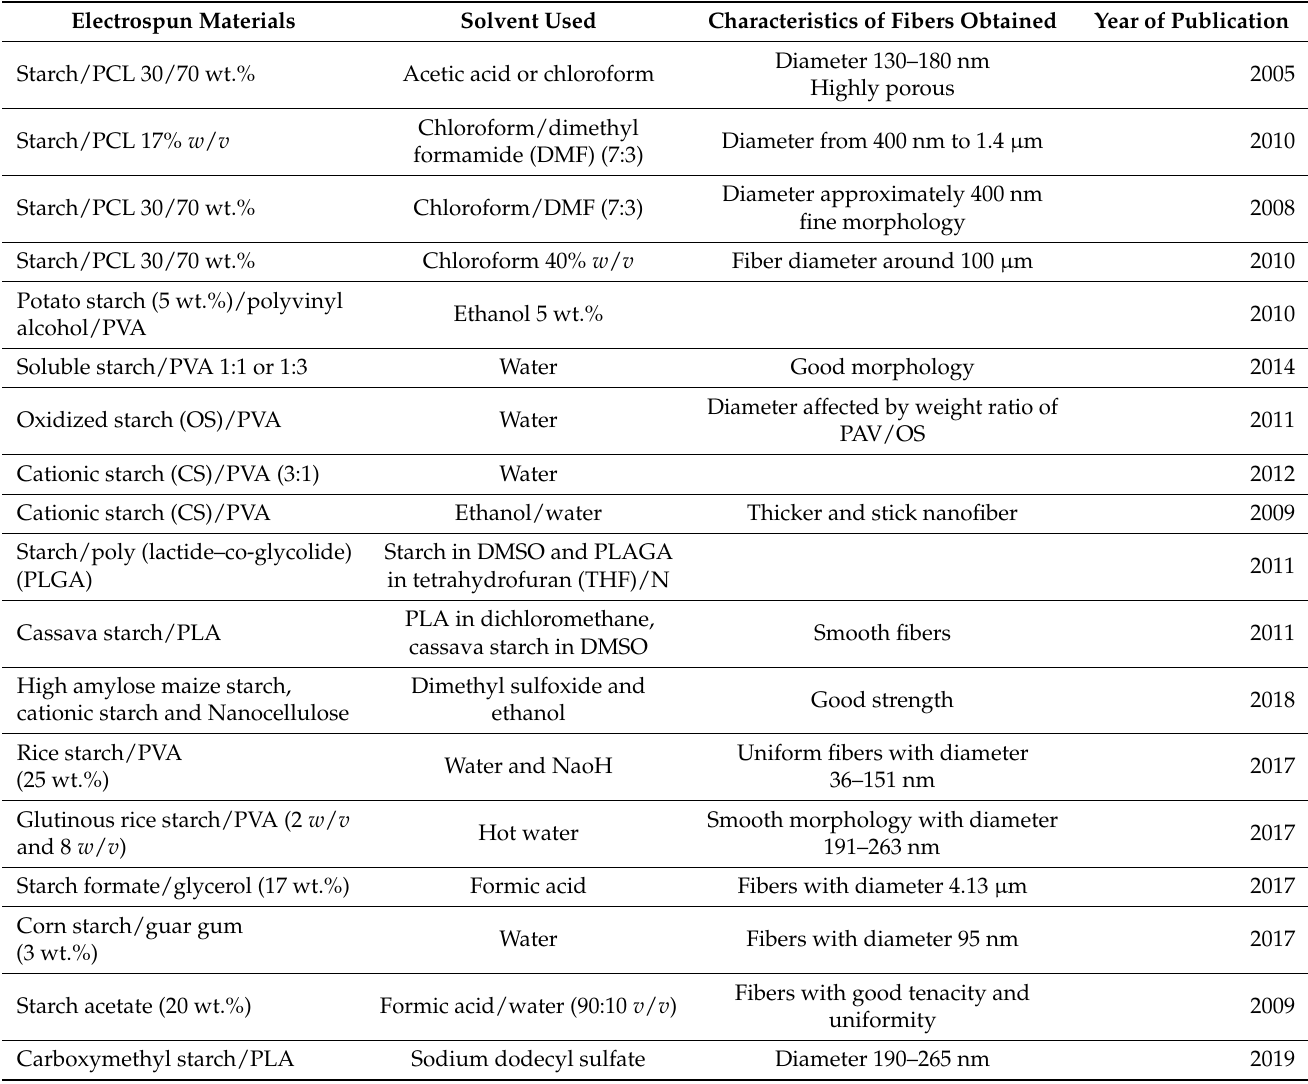
Table 4. Electrospun fibers from starch/polymer blends